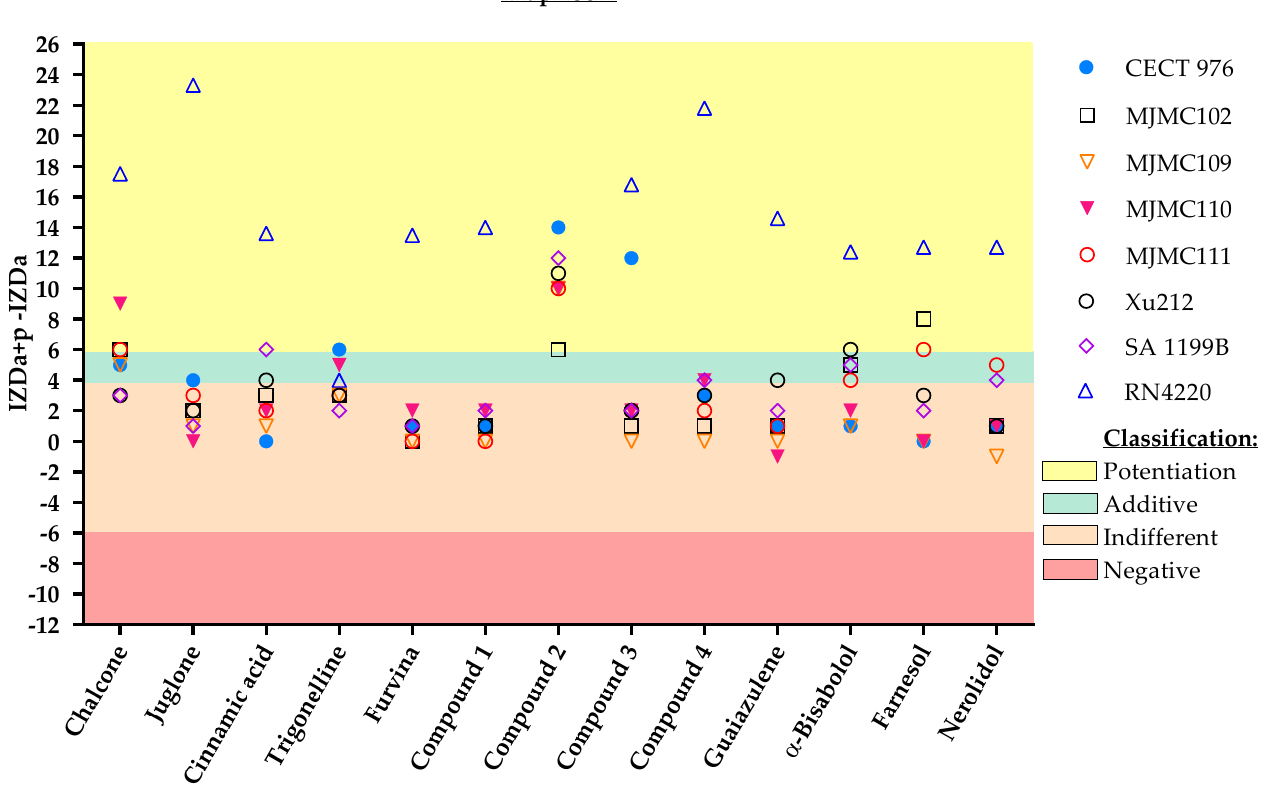
Figure 2. Inhibition zone diameter (IZD) values (mm) and respective classification according to the combined application of the selected phytochemicals and mupirocin against the eight different S. aureus strains. The effect of dual combinations of antibiotics and phytochemicals was classified as potentiation when IZDa+p–IZDa ≥ 6 mm (yellow zone), additive when 6 mm > IZDa+p –IZDa ≥ 4 mm (green zone), indifferent when 4 mm > IZDa+p–IZDa > − 6 mm (light pink zone) and negative when IZDa+p–IZDa ≤ − 6 mm (dark pink zone), where IZD corresponds to the inhibition zone diameter, a = antibiotic and p = phytochemical. Compound 2 , a nitrovinylfuran derivative, induced total growth inhibition against the RN4220 strain. More detailed information about the interactions is given in the Supplementary Materials, including some geometric shapes that might be overlayed on the graph (Table S1).